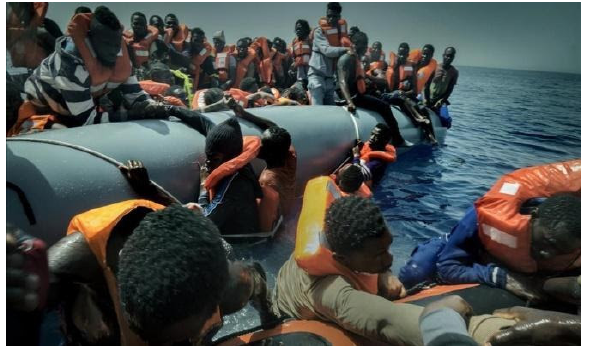
Figure 1. (Rescue) from the questionnaire. Source: Boats in the Mediterranean. Photograph by Ricardo García Vilanova. Libyan waters 2016. El Periódico.